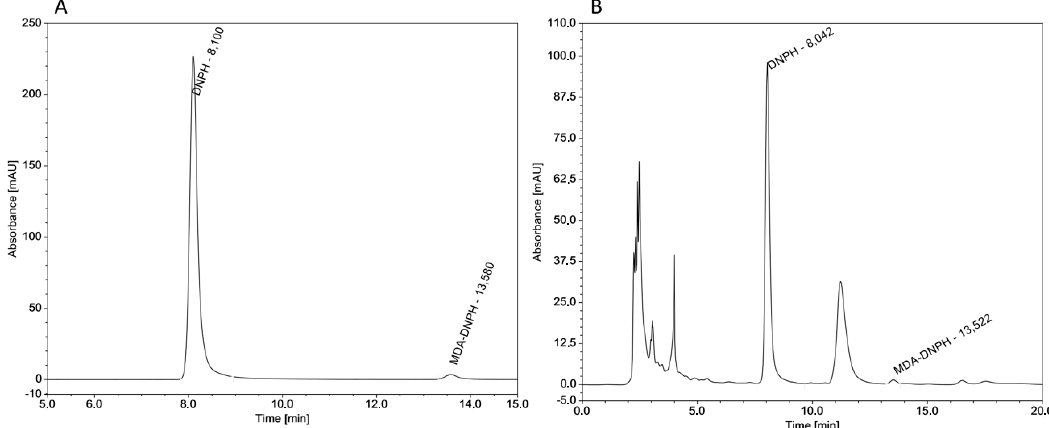
Figure 1. Chromatograms for derivatized MDA-DNPH ( A ) in standard at a concentration of 430 ng/mL and frankfurters (high-pressure MDCM) B ( B ).